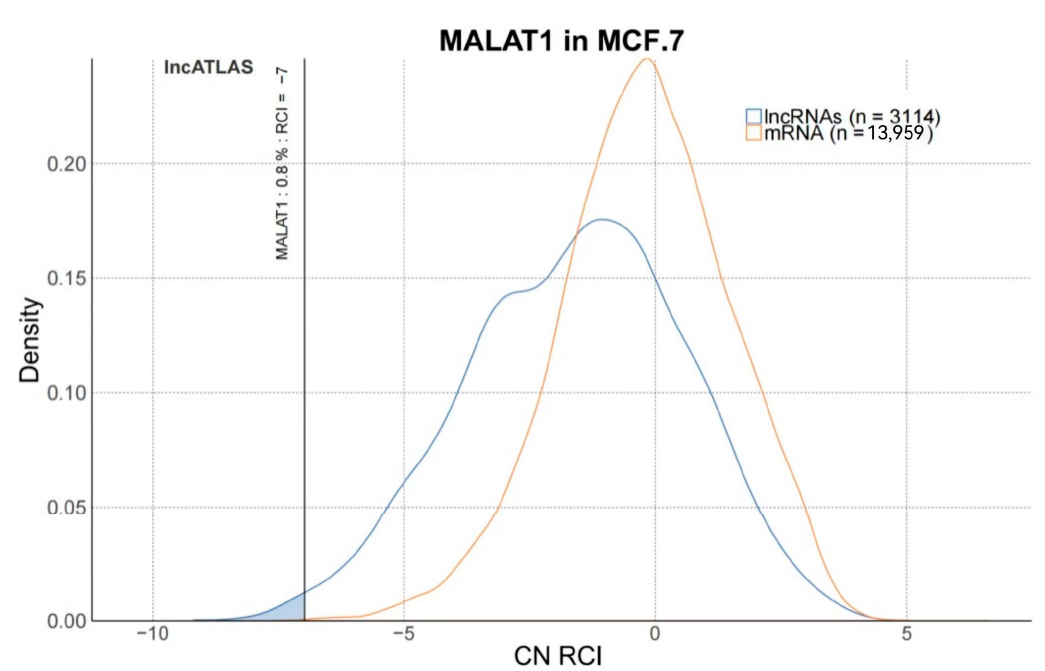
Figure 6. CN RCI values of MALAT1 in MCF.7.